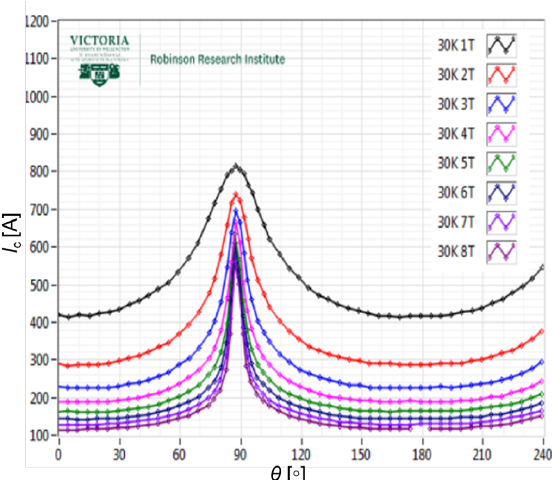
Figure 7. I c − B − θ characteristics curve of tape